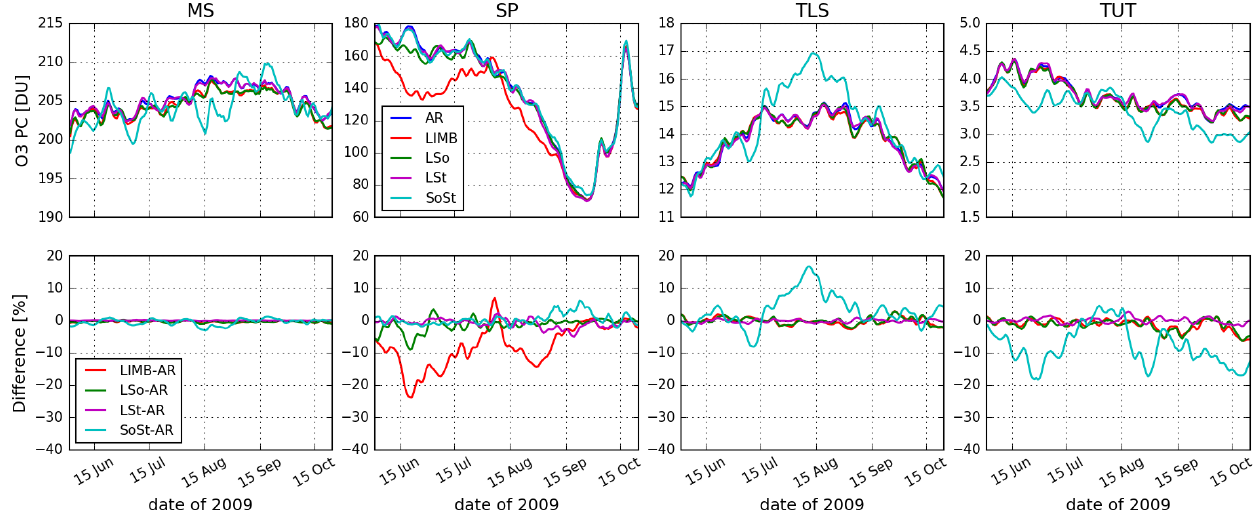
Figure 13. As Fig. 12 but showing AR (blue line), the LIMB run (red line), the LSo run (green line), the LSt run (magenta line) and the SoSt run (cyan